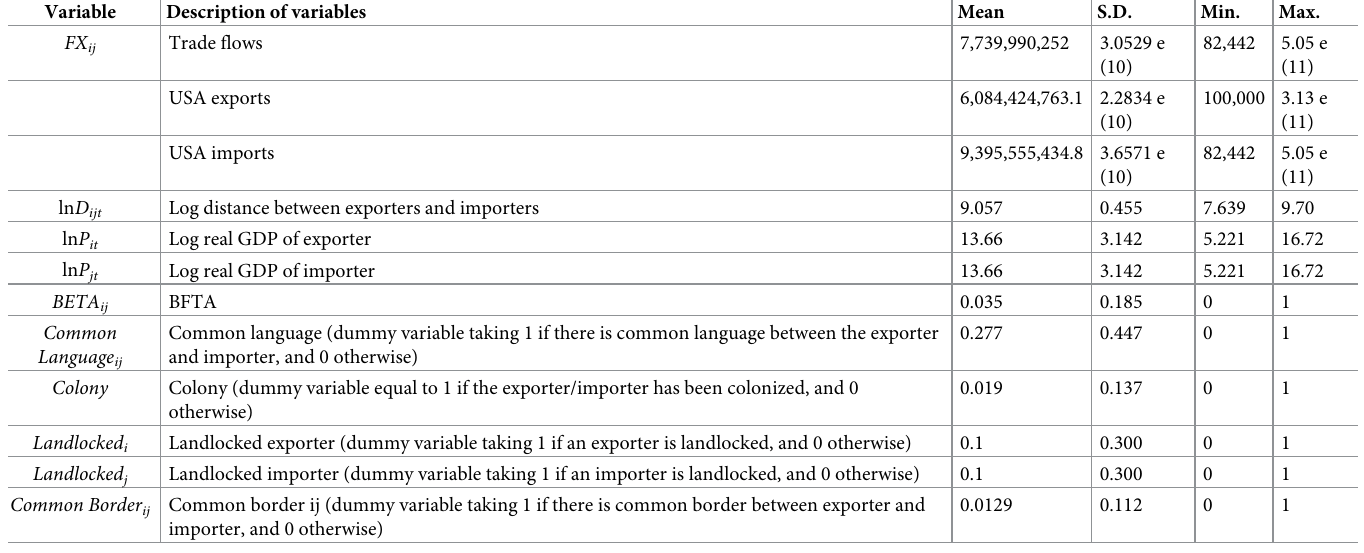
Table 3. Descriptive statistics.